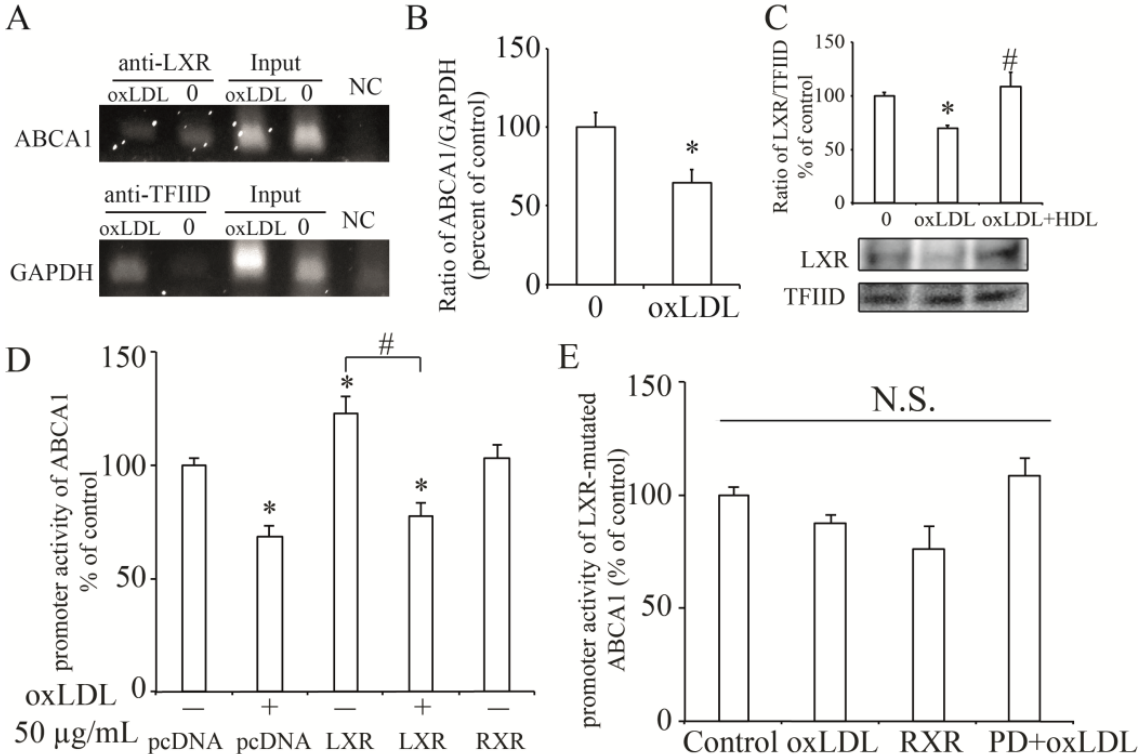
Figure 5. Roles of transcription factor, LXR in OxLDL-suppressed ABCA1 transcription. ( A ), the direct binding of LXR to ABCA1 promoter. LXR specifically immunoprecipitated ABCA1 chromatin (anti-LXR) while TFIID specifically immunoprecipitated GAPDH chromatin (anti-TFIID) in INS-1 cells by ChIP assay. No ChIP was detected when the chromatin was immunoprecipitated with negative control IgGs (NC). Input was shown as a positive control. There is no band detected when the templates were amplified by negative primer. ( B ), the effect of OxLDL on LXR-binding to ABCA1 promoter by ChIP-real time PCR. ( C ), the nuclear abundance of LXR protein in INS-1 cells treated with OxLDL or OxLDL plus HDL. ( D ), the role of LXR in ABCA1 promoter activity with OxLDL treatment. ( E ), the effect of OxLDL or inhibition of MEK on the LXR-binding sites ( G ATAG T to A ATAG G ) mutated ABCA1 promoter activity. * p < 0.05 compared to control (0, pcDNA). # p < 0.05 compared to OxLDL at 50 µg/mL(C). # p < 0.05 compared to LXR group (D). N.S., No significance.